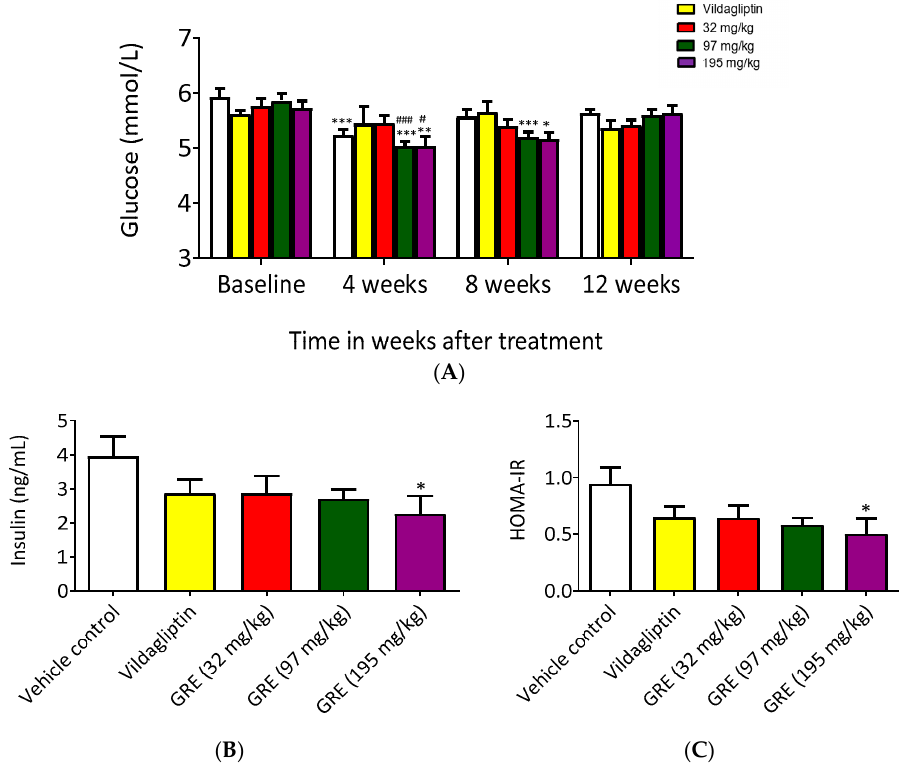
Figure 5. An aspalathin-enriched GRE attenuated insulin resistance in obese insulin resistant (OBIR) Wistar rats. Graphs depict blood glucose concentrations ( A ), insulin concentrations ( B ), and Homeostatic Model Assessment of Insulin Resistance (HOMA-IR) ( C ). OBIR rats were treated daily with GRE. Body weights and blood glucose concentrations were measured at baseline, four weeks, eight weeks, and 12 weeks. The effect of different doses of GRE (32, 97, and 195 mg/kg body weight) was assessed in terms of the reduction in glucose concentrations in comparison to a known HOMA-IR, calculated from fasting glucose and insulin concentrations after 12 weeks of treatment. Results are presented as mean ± SEM of OBIR rats ( n = 6). * p ≤ 0.05, ** p < 0.01, *** p < 0.001, versus respective baseline values; # p ≤ 0.05, ### p < 0.001 versus untreated control at 4 weeks after treatment. Baseline indicates measurements taken before